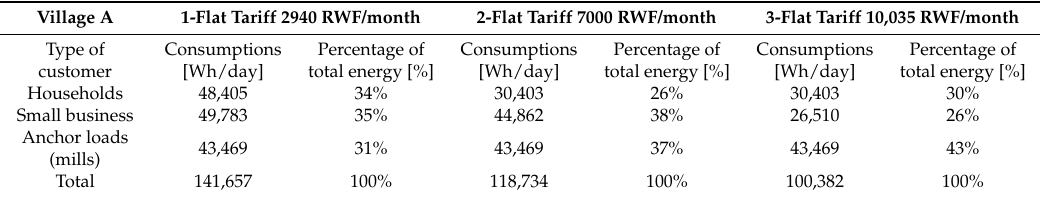
Table 5. Current energy demand by type of consumer.